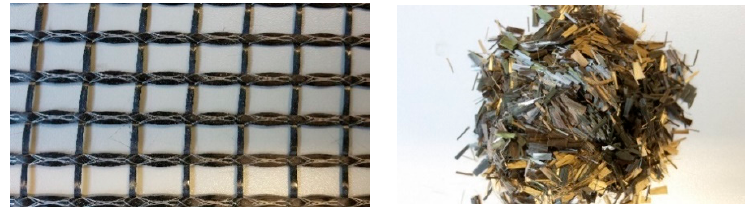
Figure 1. Carbon textile and chopped basalt fiber used in this work. Table 1. Properties of carbon textile.